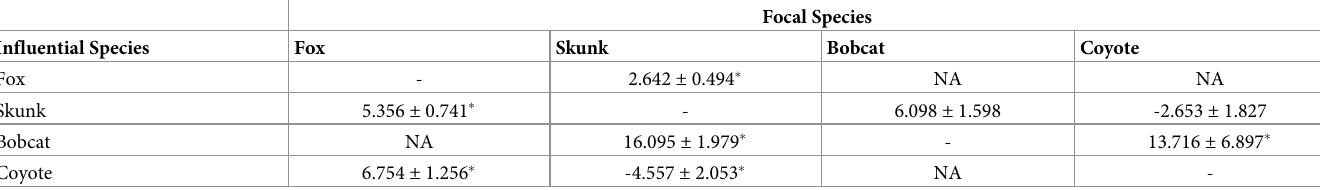
Table 4. Beta estimates for multi-species co-occurrence from stage